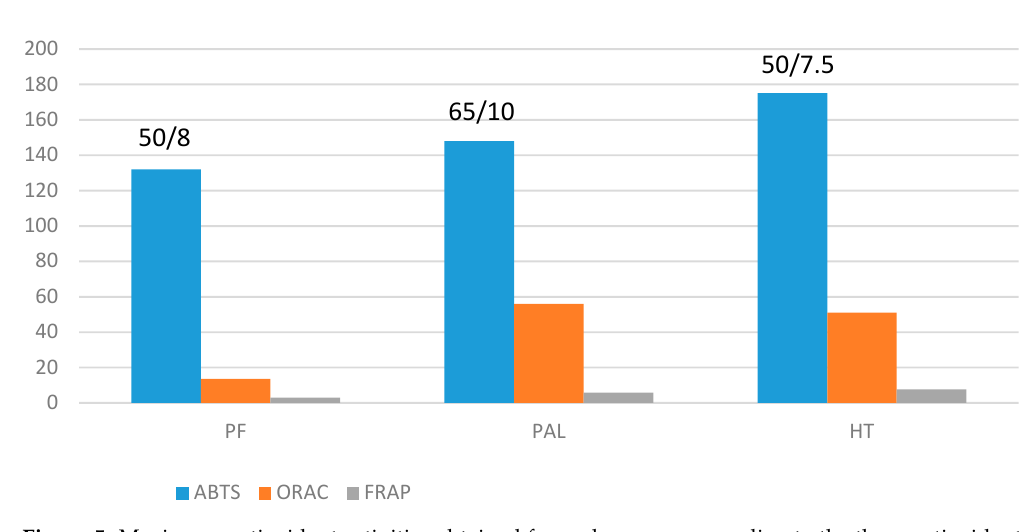
Figure 5. Maximum antioxidant activities obtained for each enzyme according to the three antioxidant activity methods: ABTS ( µ mol Trolox / g fish), FRAP (mg ascorbic acid / g fish) and ORAC ( µ mol Trolox / g fish); numbers over ABTS bars indicate T / pH conditions for hydrolysate production.